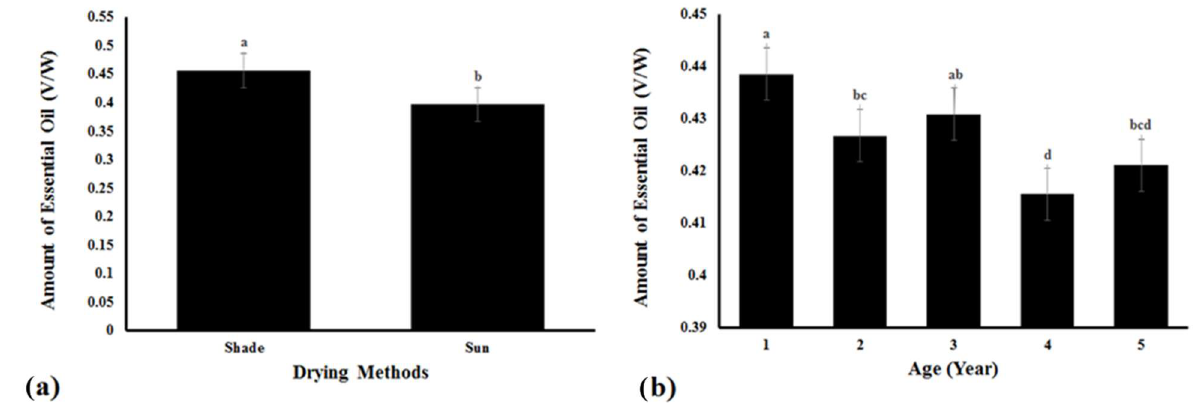
Figure 1. The average of the mutual effects between drying methods and age of plant on the extracted essential oil. Bar graph of amount of EO yield ( ± 1 SD) for: ( a ) Drying methods (shade vs. sun), and ( b ) Age of plant (years old) between treatment means using Duncan’s multiple range test. Values with the same letter (a–d) are not significantly different at p = 0.01.